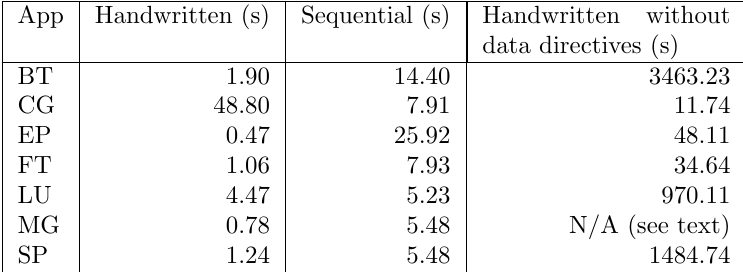
Table 3: The handwritten OpenACC implementation’s execution time com- pared to its variant without data directives (timeout is 2